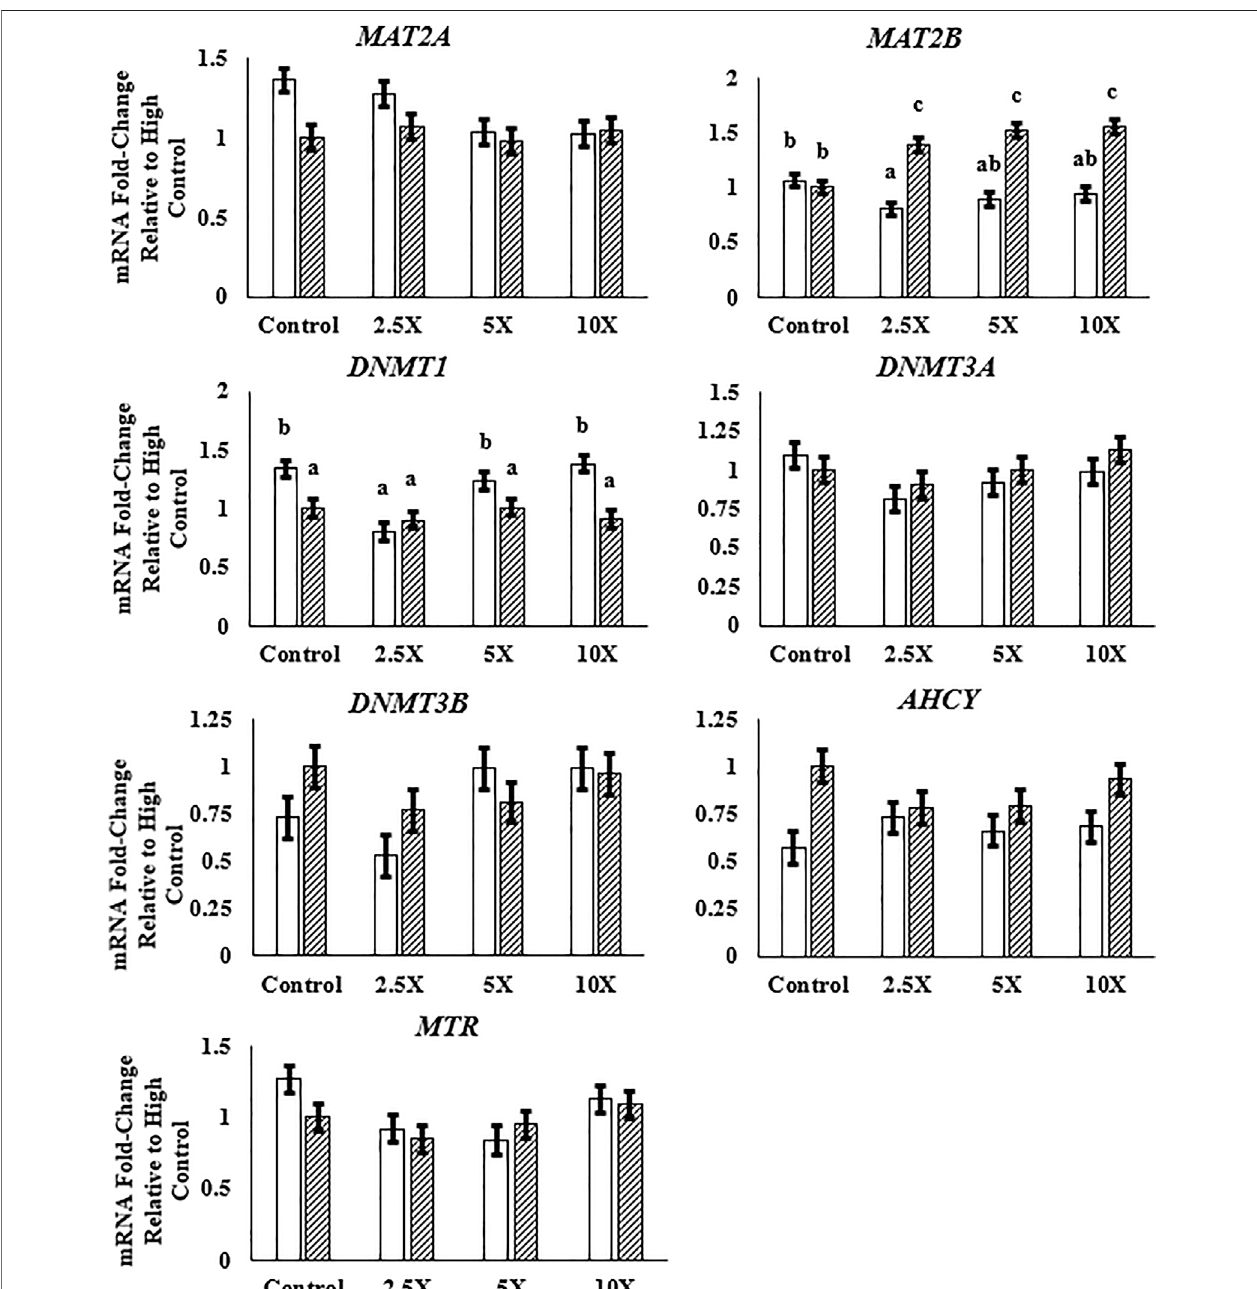
FIGURE 4 | The expression of MAT2B is greater with epigenetic modi fi er (EM) supplementation in High cells, and DNMT1 expression is lower in High compared with Low cells. High glucose cells are represented by the dashed bar. MAT2A, methionine adenosyltransferase 2A; MAT2B, methionine adenosyltransferase 2B; DNMT1, DNA methyltransferase 1; DNMT3A, DNA methyltransferase 3A; DNMT3B, DNA methyltransferase 3B; AHCY, S-adenosylhomocysteine hydrolase; MTR, methionine synthase. Low glucose cells are represented by the solid white bar. High glucose cells are represented by the dashed bar. Means without a common superscriptdifferinglucose×EM( p ≤ 0.05).Onlymeansthataresigni fi cantfortheglucose×EMinteractionwillhavemeanseparation.Threereplicatespertreatmentper timepoint were measured. Error bars represent the average standard error of the mean within a glucose level.